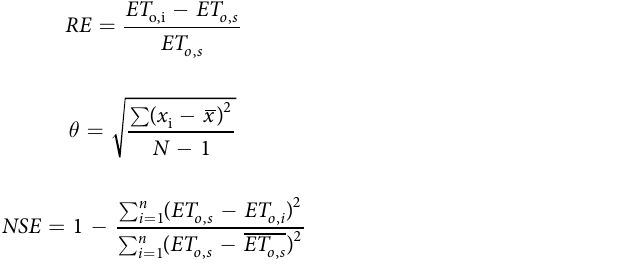
4 Scientific RepoRts | 7: 5458 | DOI:10.1038/s41598-017-05660-y